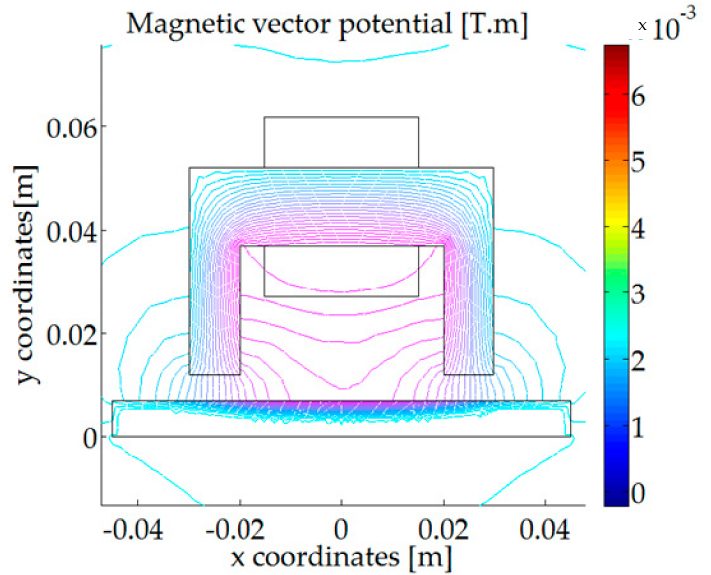
Figure 5. Steady-state distribution of the magnetic vector